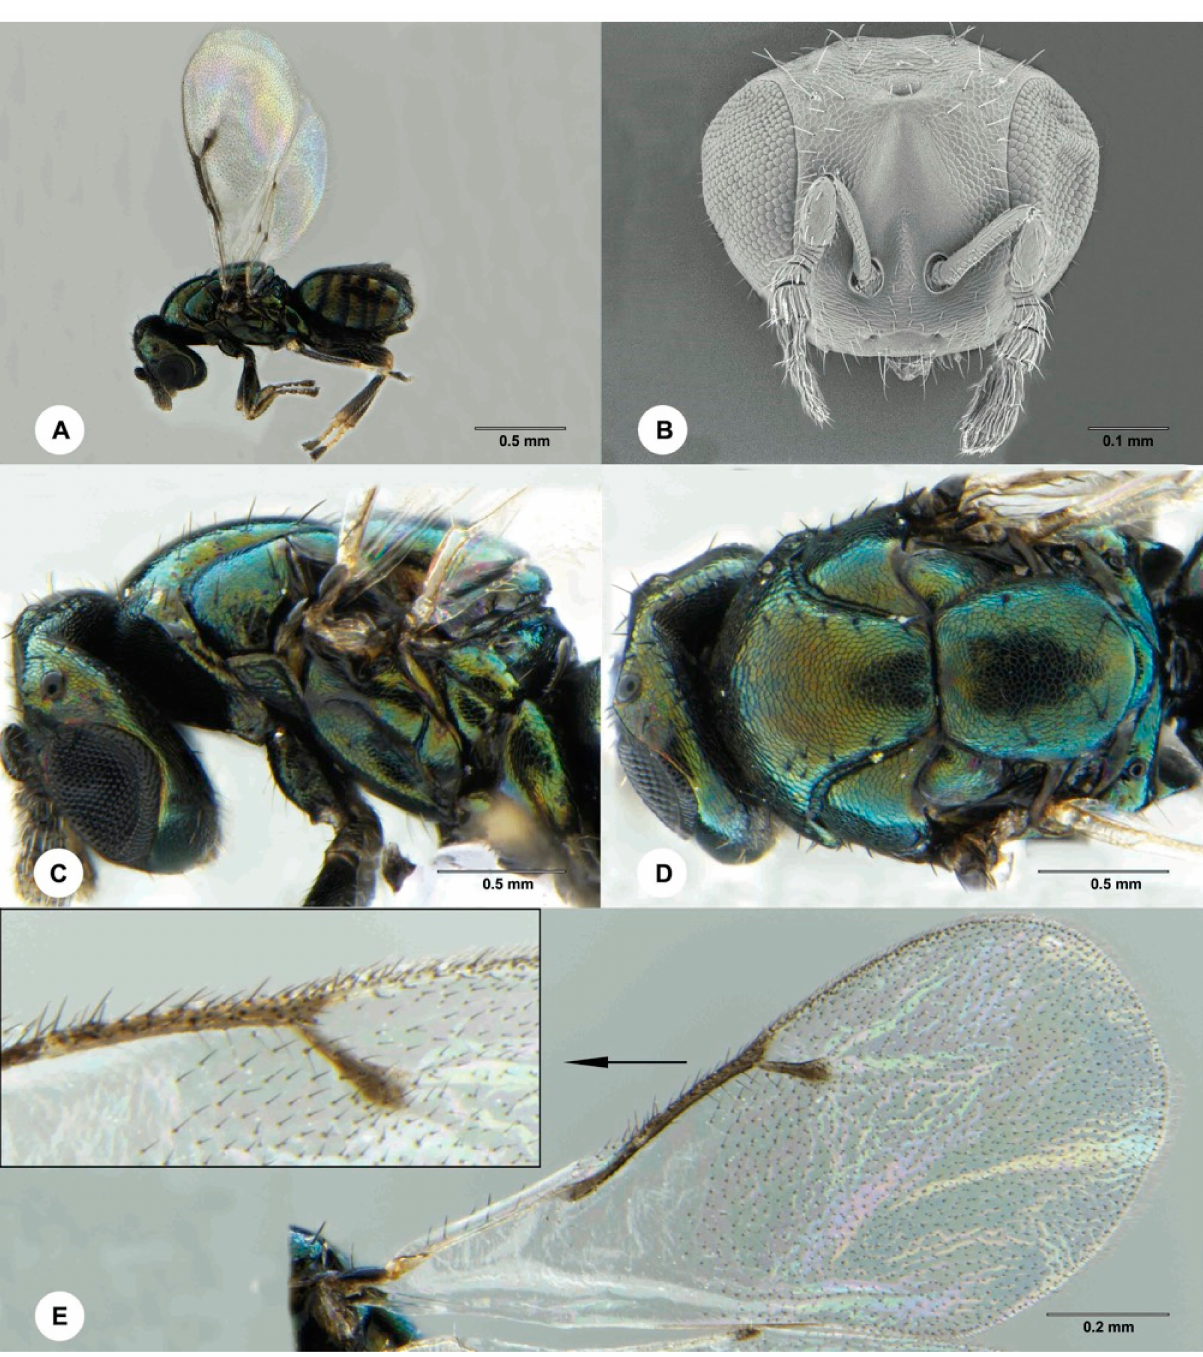
Figure 5. Ophelimus bipolaris sp. n., female ( A ) Habitus, lateral view ( B ) Head, anterior view ( C ) Head and mesosoma, lateral view ( D ) Head and mesosoma, dorsal view ( E ) Fore wing. Antenna: Pedicel slight shorter then funicle. First four flagellomeres anellifrom, the last also transverse but much larger and bearing multiporous plate sensilla. Club longer than the other flagellmeres combined, ovate, with three distinct clavomeres, the apical one bearing a long terminal